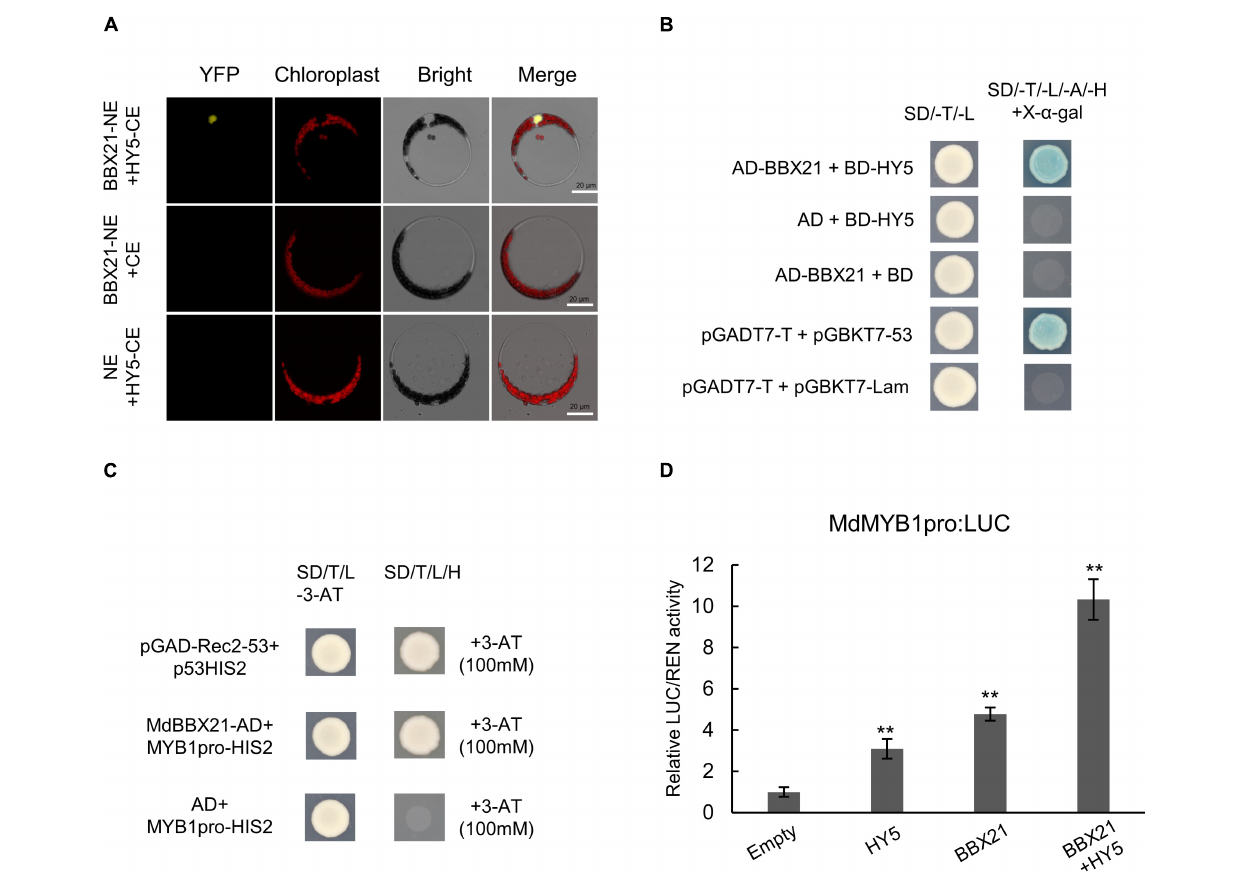
FIGURE 8 | The interaction between MdBBX21 and MdHY5 can significantly enhance MdMYB1 promoter activity. (A) Bimolecular fluorescence complementation assay. (B) Yeast two-hybrid assay showing interaction between MdBBX21 and MdHY5. (C) Yeast one-hybrid assay showing interaction between MdBBX21 and MdMYB1 promoter. (D) Effects of MdBBX21 and MdHY5 individually and in combination on promoter activity of MdMYB1 as determined by luciferase reporter assay. Error bars represent the standard deviation of three biological replicates. ** P < 0.01 (Student’s t